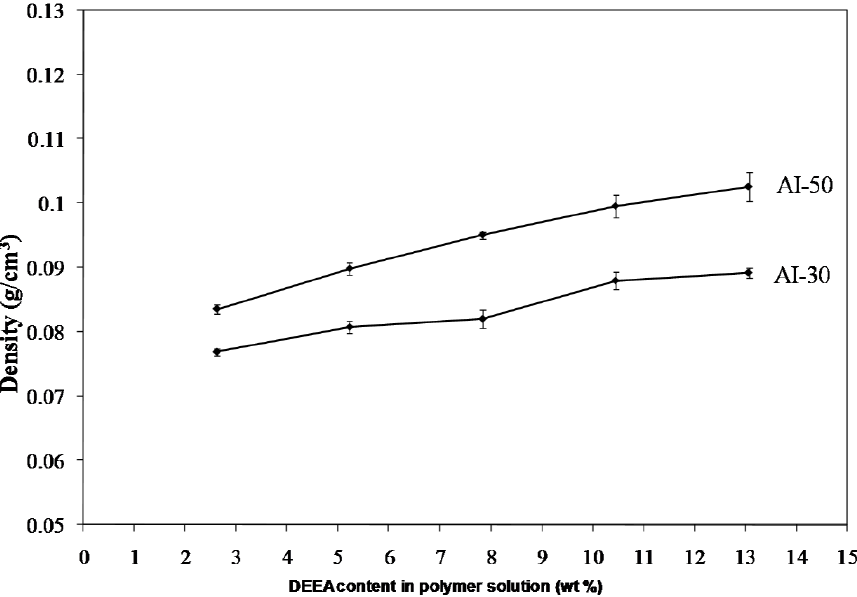
Figure 3. Change in density of 5 wt.% Na + -MMT/2.5 wt.% AI-30 composites as a function of amine concentration.